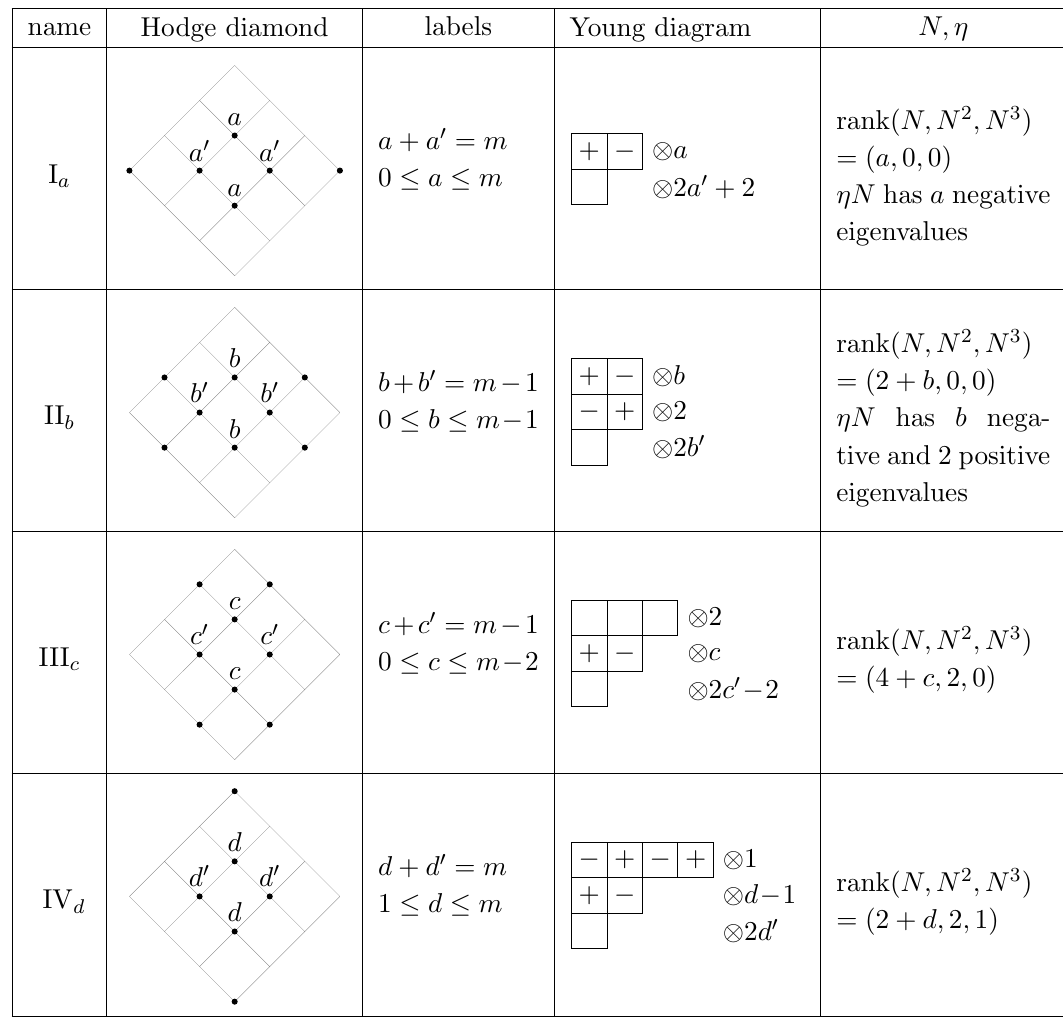
Table 1 . The 4 m possible limiting Hodge diamonds with Hodge numbers h 2 ; 1 = m . The label next to a dot at a point ( p; q ) represents the value of i p;q . A dot at ( p; q ) without a label represents i p;q =